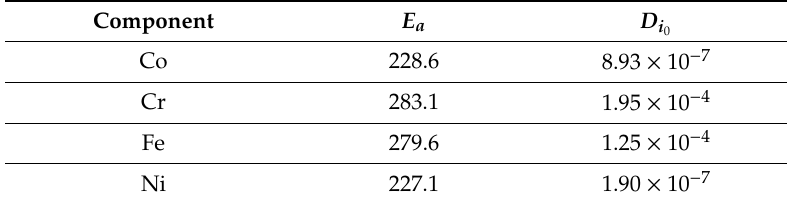
Table 5. Energies of activation (kJ · mol − 1 ) and pre-exponential factors (m 2 · s − 1 ) obtained for the tracer di ff usion coe ffi cient by means of Levenberg–Marquardt method for the Al-Co-Cr-Fe-Ni system